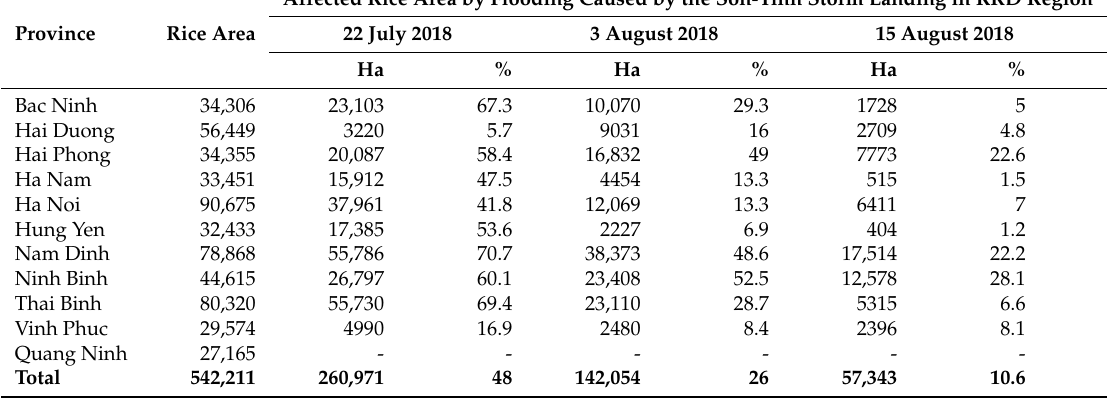
Table 11. Inundated rice area estimation for 10 provinces during the Son-Tinh storm occurrence. Affected Rice Area by Flooding Caused by the Son-Tinh Storm Landing in RRD Region Province